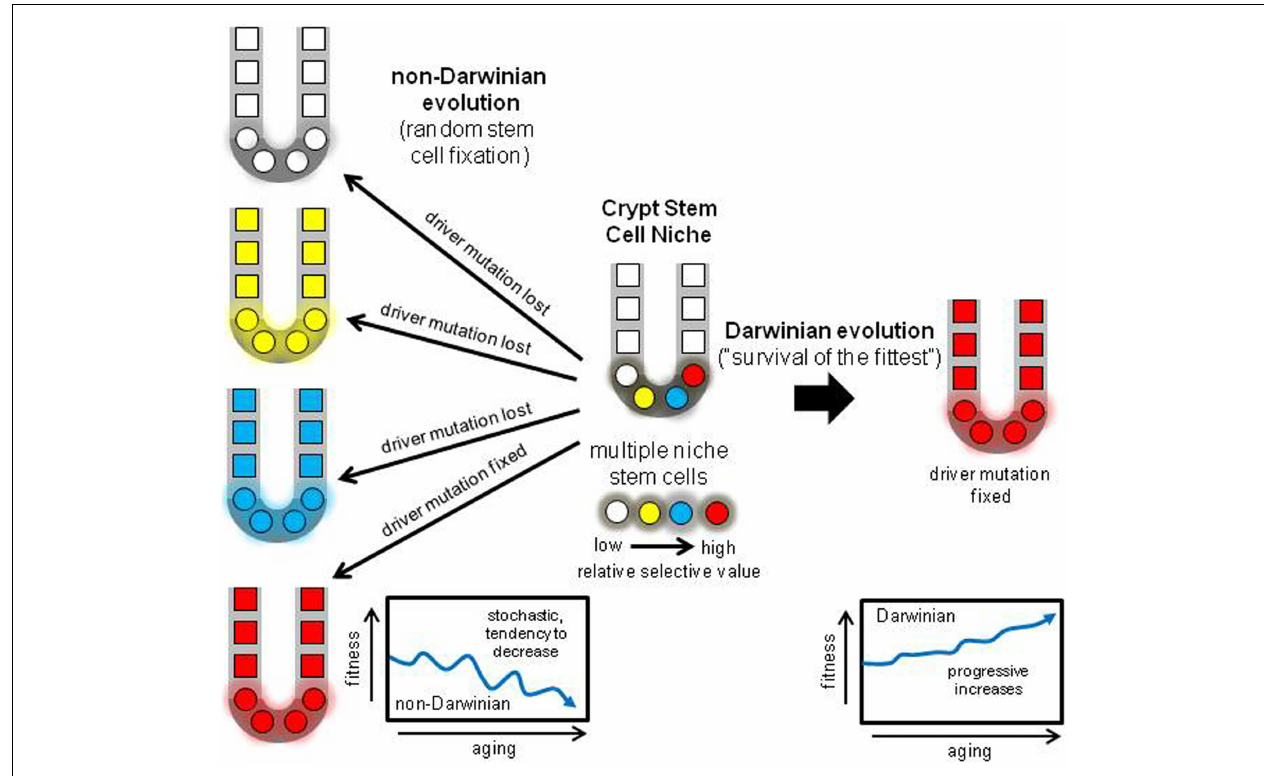
small niche populations, chance or drift more determines niche succession, and almost any stem cell may become fixed, even stem cells with lower relative fitness.The result is the random loss of many driver mutations, and more consistent with aging, a stochastic tendency for decreased crypt